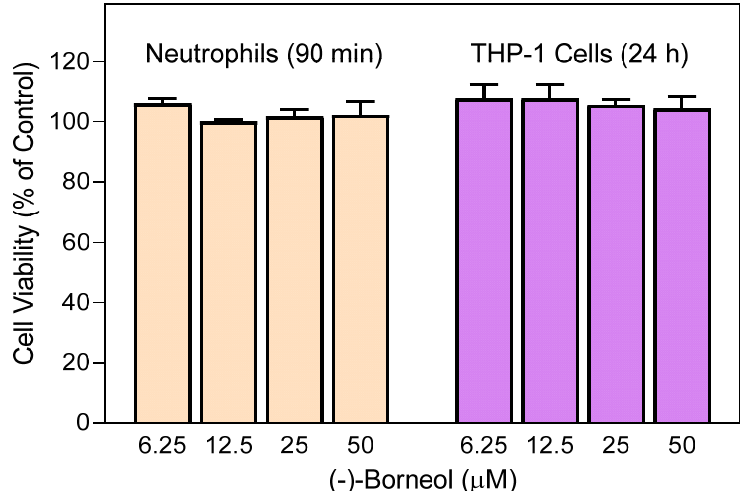
Figure 4. Cytotoxicity of ( − )-borneol. Human neutrophils or human THP-1 monocytic cells were preincubated with indicated concentrations of ( − )-borneol for 90 min or 24 h, and cell viability was analyzed, as described. Values are the mean ± SD of triplicate samples from one experiment that is representative of three independent experiments with similar results.